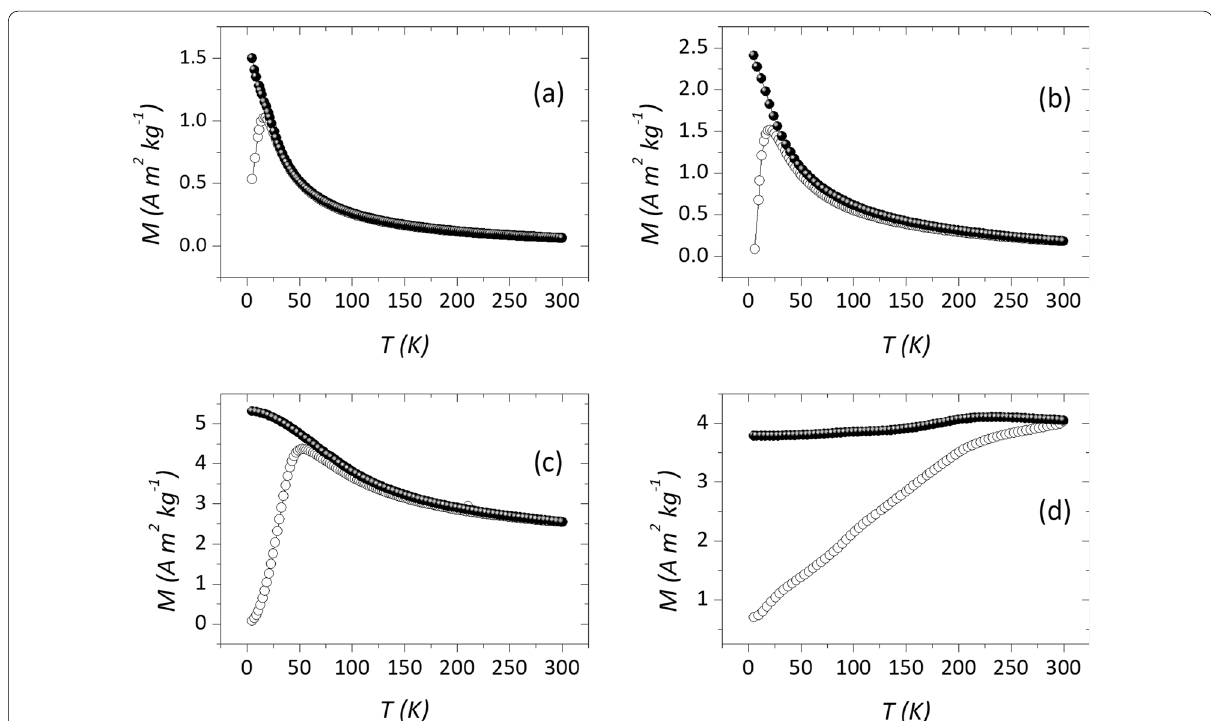
Fig. 2 ZFC (empty circles) and FC (full circles) curves for samples MAG1 ( a ), MAG2 ( b ), MAG3 ( c ), and MAG4 ( d ), measured with an applied field of 2.5 mT